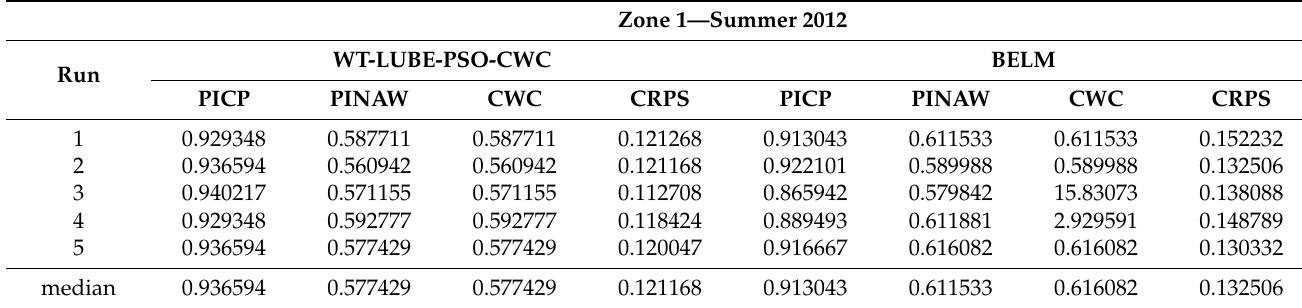
Table 3. Results of the evaluation of 5 training sessions of WT-LUBE-PSO-CWC and BELM models in zone 1 for summer 2012 at the 0.9 confidence level.